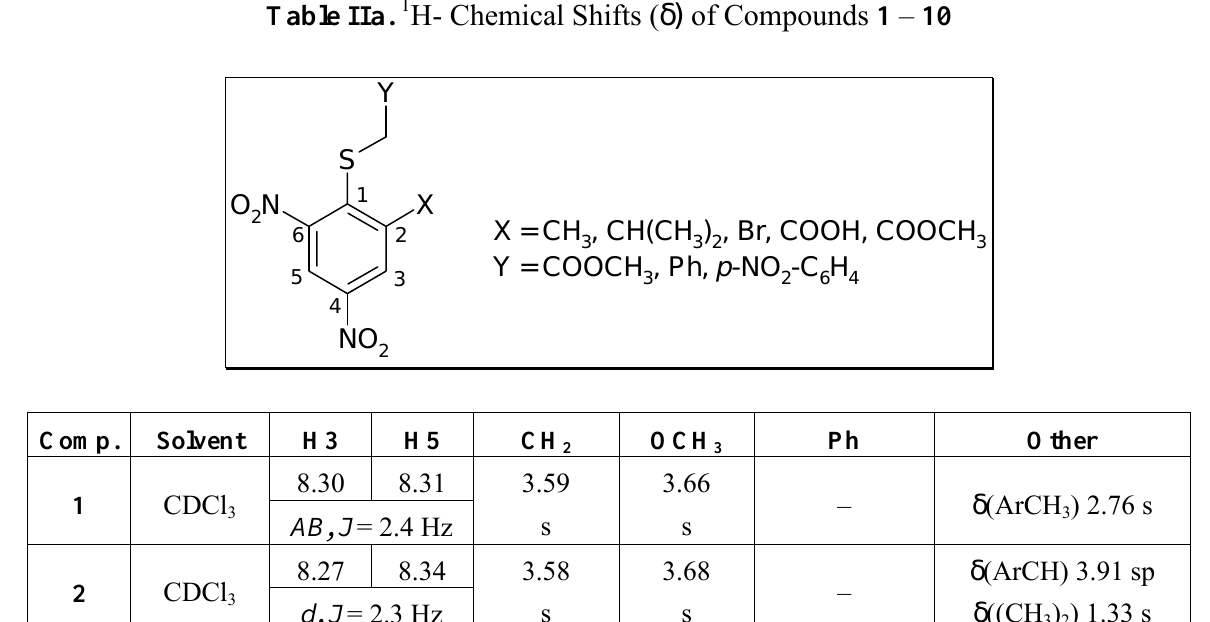
Table IIa. 1 H- Chemical Shifts ( δ) of Compounds 1 (cid:150)